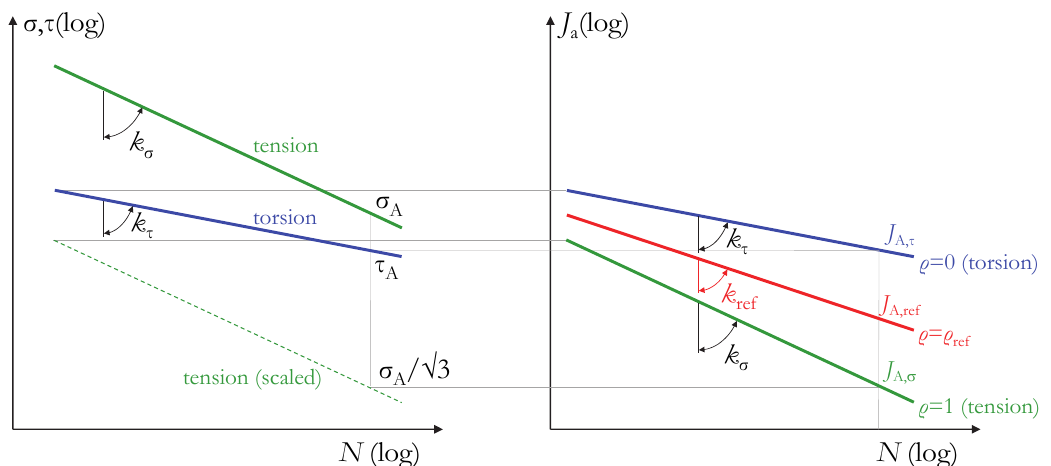
Figure 3: Relationship between S-N lines in Wöhler diagram (left) and Modified Wöhler Diagram (right). The reference S-N line for a general multiaxial stress ( ρ = ρ ref ) is also shown. Symbol J a stands for